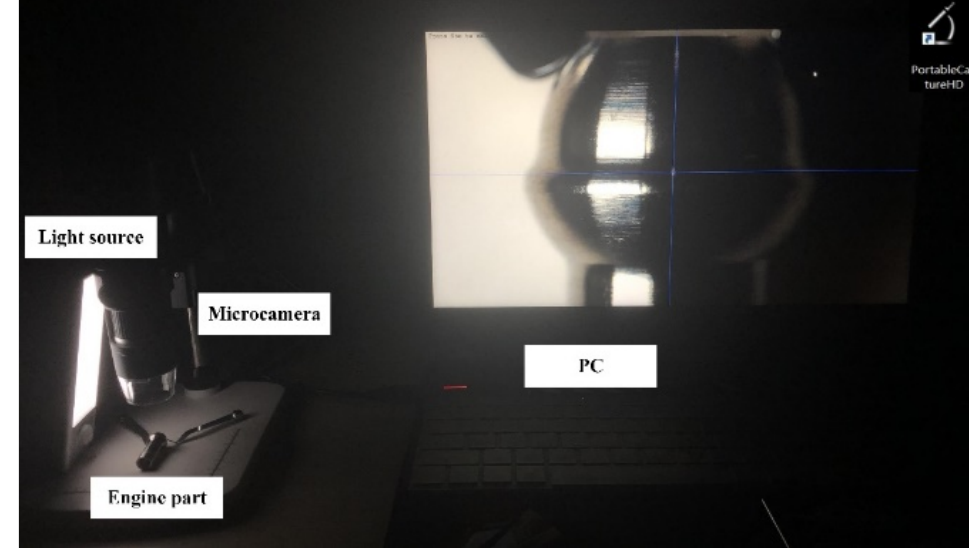
Figure 10. Image acquisition equipment for automotive engine parts.